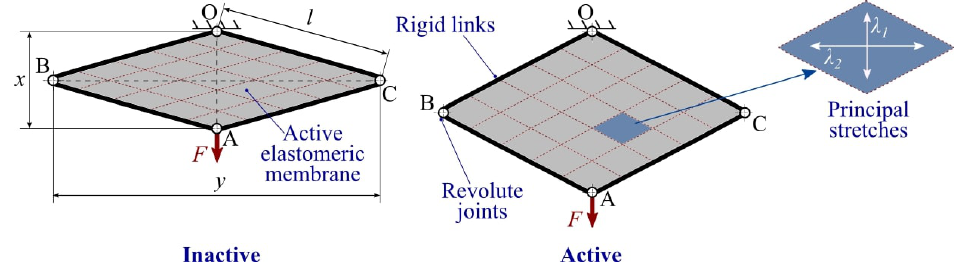
Figure 1. Layout and operating principle of an LS-DEA: Applying a voltage on the LS-DEA electrodes causes an expansion in the active membrane surface, corresponding to a variation in the lengths of the lozenge mechanism diagonals. The detail of the principal stretch directions acting on a material element is shown on the